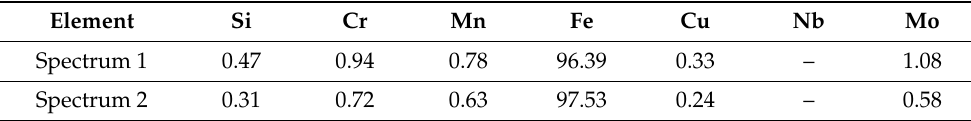
( b ) Figure 16. SEM images of carbides in segregations ( a ) and in base metal ( b ) in CT. Chemical composition (Table 7) shows that in carbides in segregations the content of molybdenum is increased.